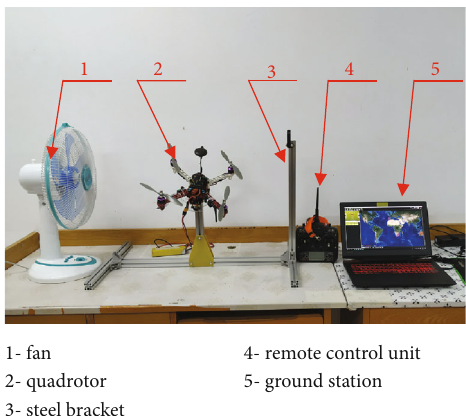
Figure 12: The structure of the quadrotor